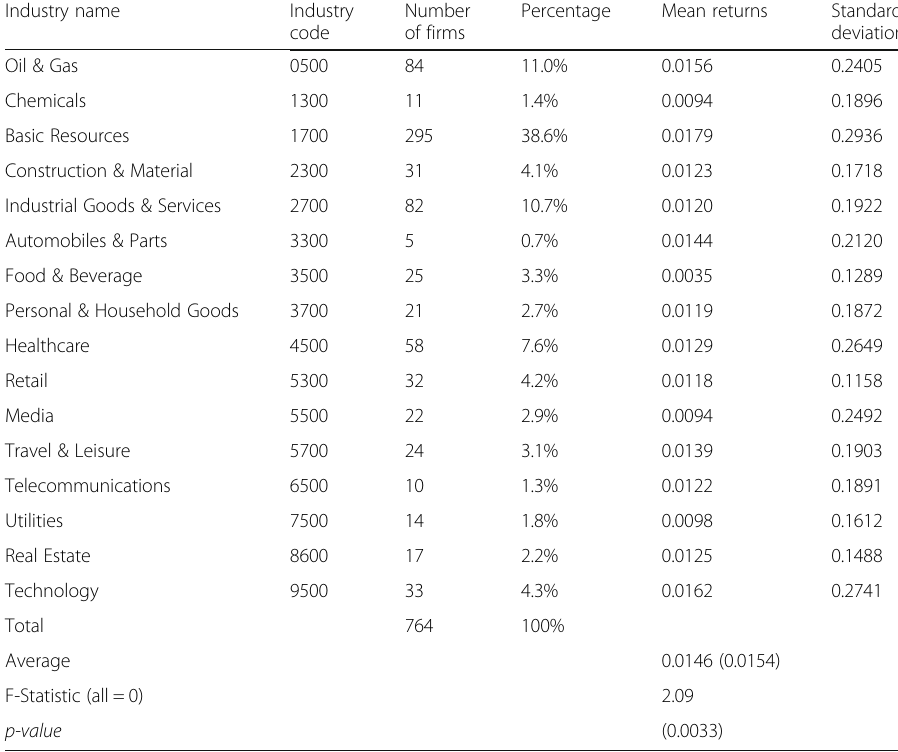
Table 2 Summary Statistics of Industries (September 1995 to September